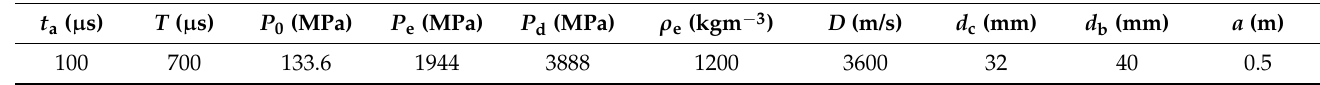
Table 2. Explosives properties for this project.